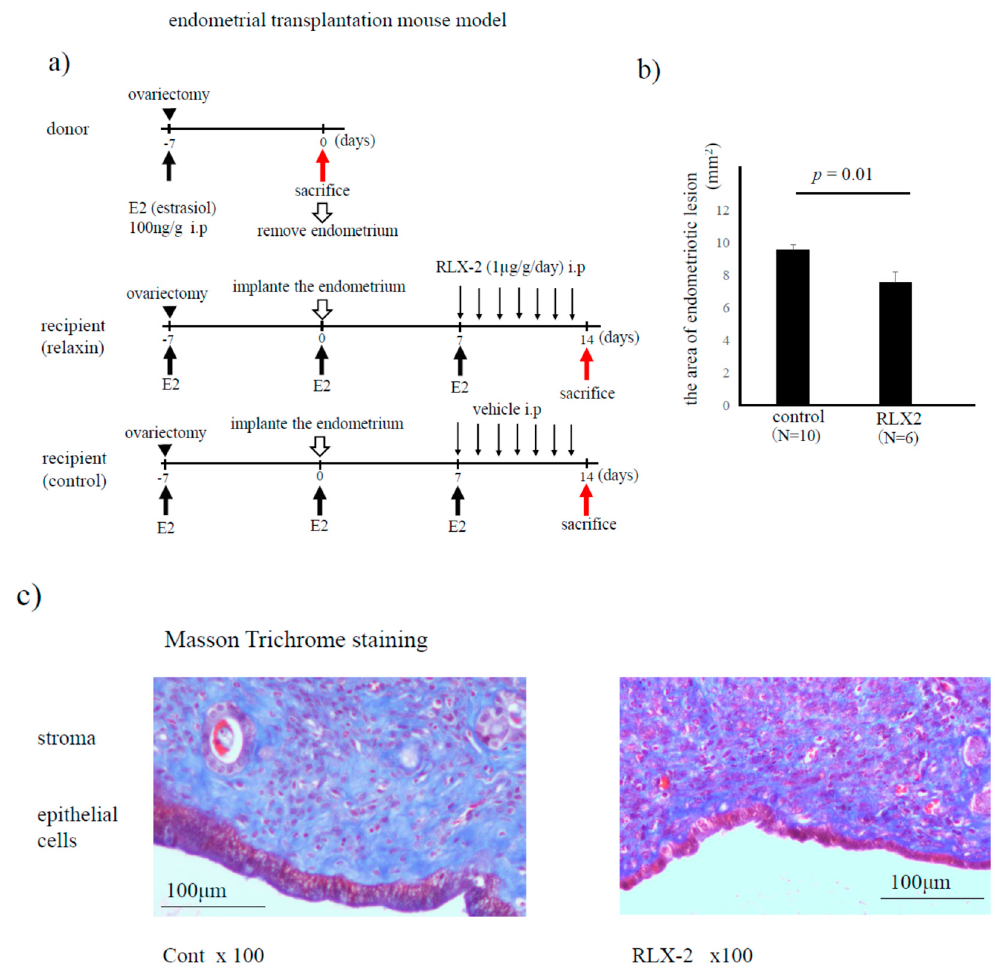
Figure 5. Endometrial transplantation mouse model. Both donor and recipient mice were treated